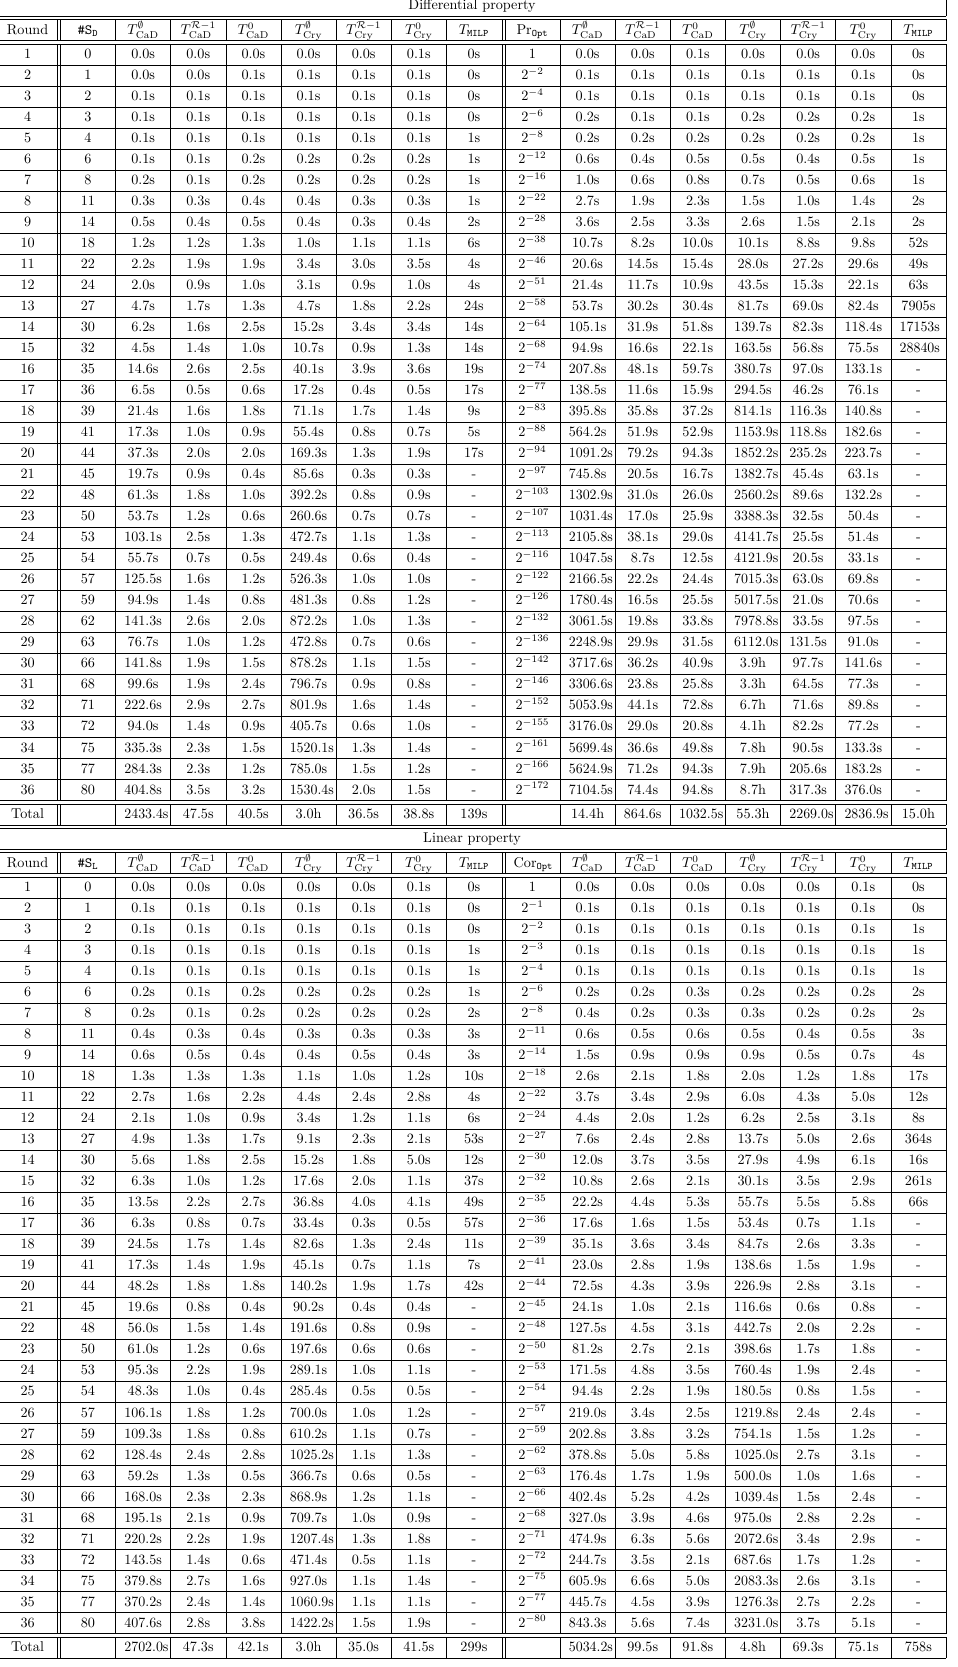
Table 16: Experimental results of TWINE